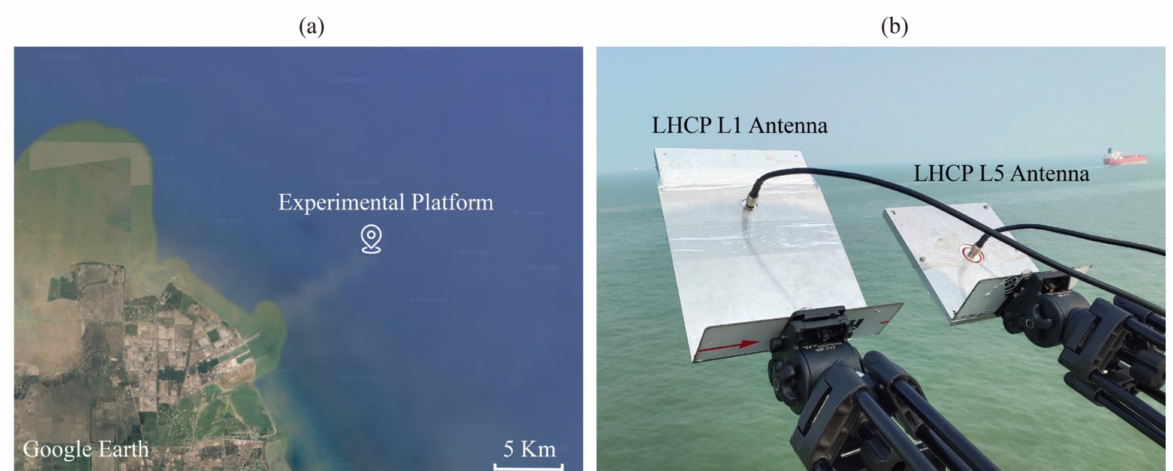
Figure 4. GNSS-R experiment setup at Dongying, China. ( a ) Aerial image (Google Earth) of the experimental site. ( b ) Photograph of the side-looking LHCP antennas, including the GPS L1 antenna and GPS L5